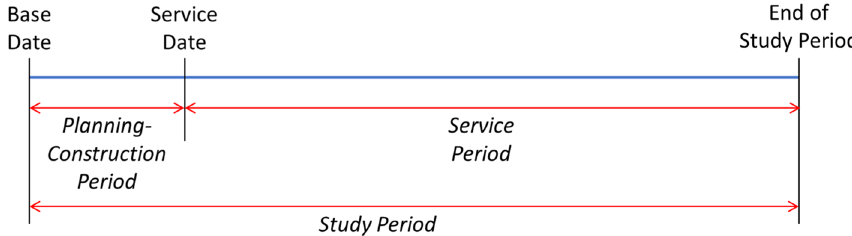
Fig. 6 Description of study period used in economic feasibility analysis of passive